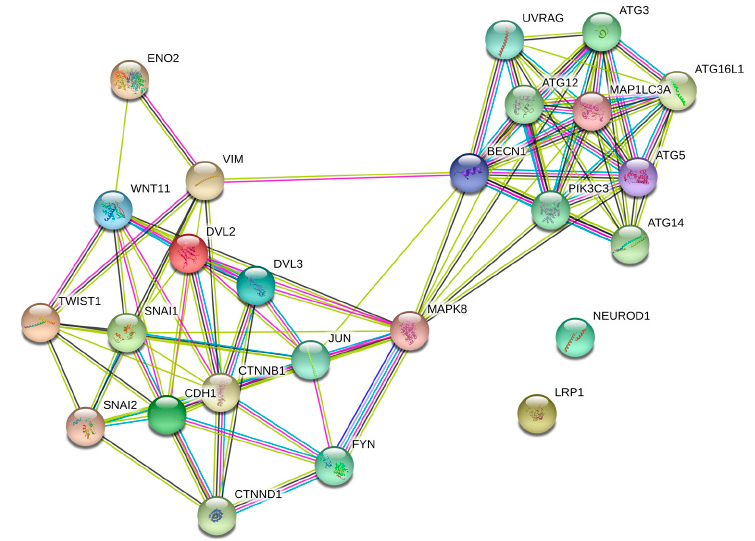
Figure 7. The putative binding partners of Wnt-11 and JNK were shown by using STRING (Search Tool for the Retrieval of Interacting Genes/Proteins) analysis (https://string-db.org/; STRING combined score > 0.4) [37]. Lines between nodes represent known interactions (from curated databases: blue; experimentally determined: pink), predicted interactions (gene neighbourhood: green; gene fusions: red; gene co-occurrence: blue) and other interactions (text mining: lime green; co-expression: black; protein homology: grey). Red and green circles represent query proteins and the first shell of interactors’ functional involvement of proteins.